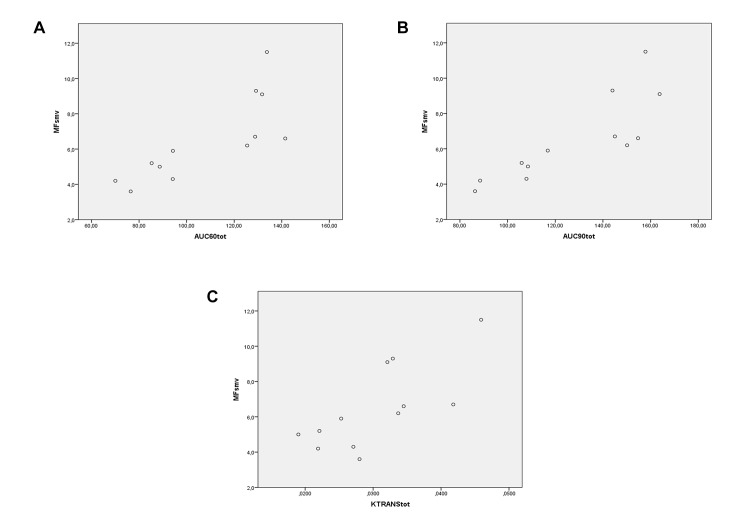
Spearman rank correlation analysis.Correlation between MRI perfusion parameters (on the horizontal axis)—AUC60 (A), AUC90 (B), and Ktrans (C)—in the whole small bowel—of PNH patients and MF of SMV (on the vertical axis).